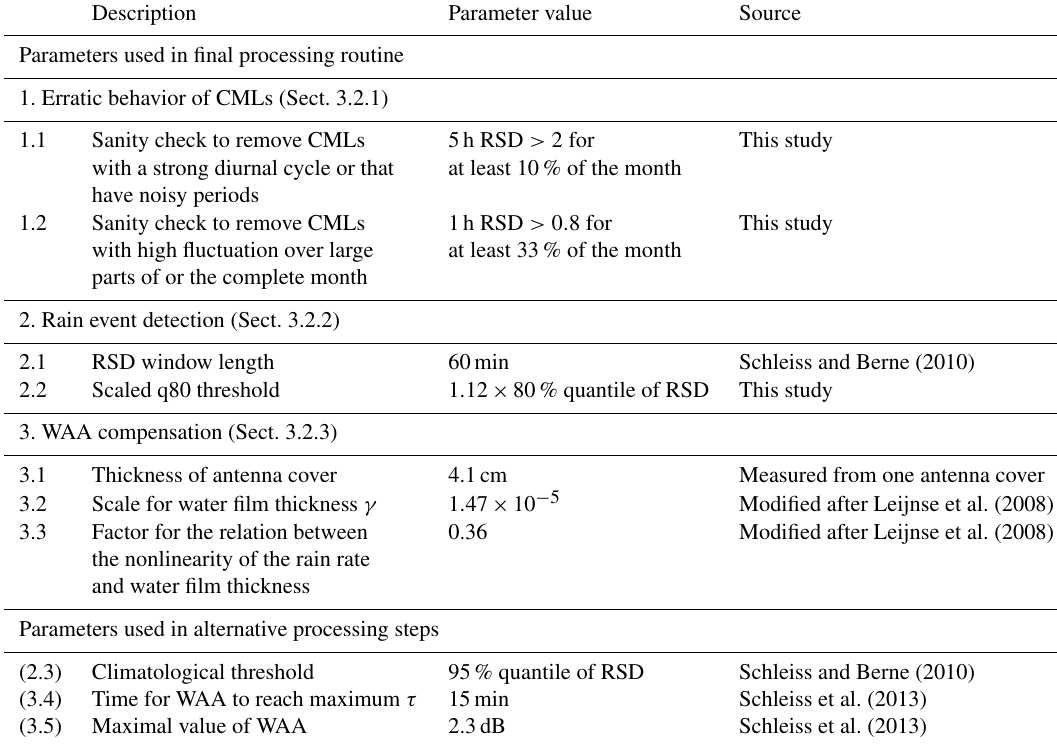
Table A1. A comprehensive overview of the parameters used, a short description, and their reference from the literature (if applicable). Parameters with enumeration in parentheses were not used in the final